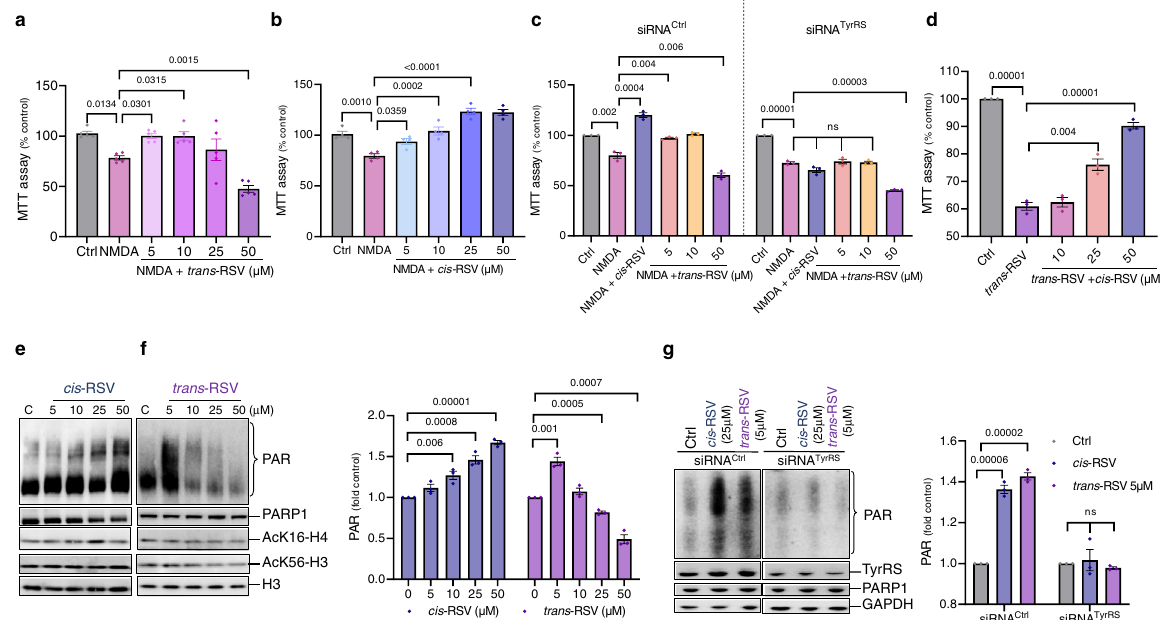
Fig. 7 Cis - and trans -RSV have opposite effects on the auto-PARylation of PARP1 and neuronal survival under stress. a Trans-RSV exacerbates NMDA- mediated neurotoxicity . Rat cortical neurons (DIV 9) were treated with NMDA (50 µ M for 5 min) and then with trans -RSV (5 – 50 μ M) for 24 hr. Cells were then exposed to NMDA (500 µ M for 5 min), and viability was assessed using MTT assay after 24 hr. Data represents n = 5 experiments. b Cis-RSV provides dose-dependent neuroprotection against NMDA-mediated neurotoxicity . Rat cortical neurons (DIV 9) were treated with NMDA (50 µ M for 5 min) and then with cis -RSV (5 – 50 μ M) for 24 hr. Cells were then exposed to NMDA (500 µ M for 5 min), and viability was assessed using MTT assay after 24 hr. Data represents n = 4 experiments. c TyrRS knockdown blunts the neuroprotective effects of cis-RSV and exacerbates the neurotoxicity of trans-RSV . Rat cortical neurons (DIV 7) were transfected with TyrRS or control siRNA (75 nM) and then treated with cis -RSV (50 µ M) or trans -RSV (5, 10, 50 µ M) for 24 hr. Neurons were then exposed to excitotoxic NMDA (500 µ M for 5 min), and viability was assessed using MTT assay after 24 hr. d cis-RSV protects from trans-RSV-mediated neurotoxicity . Rat cortical neurons (DIV 8) were treated with trans -RSV alone or combined with different doses of cis -RSV (10 – 50 μ M) for 48 hr, and viability was measured using MTT assay. e , f Cis-RSV and trans-RSV have opposite effects on the auto-PARylation of PARP1 . Representative immunoblot images and quanti fi cation using speci fi c antibodies for PARylation, PARP1, AcK16-H4, AcK56-H3 levels after treatment of cortical neurons (DIV 9) with cis - and trans -RSV for 15 min. g cis-RSV and low dose trans-RSV-dependent auto-PARylation of PARP1 is TyrRS dependent . Rat cortical neurons (DIV 7) were transfected with control and TyrRS siRNA followed by treatment with cis - (25 μ M) and trans -RSV (5 μ M) for 15 min and immunoblotting and quanti fi cation using the speci fi c antibodies for PARylation, PARP1 and TyrRS. All data represent mean ± SEM for n = 3 experiments with signi fi cance measured using ANOVA with Dunnett ’ s test for multiple